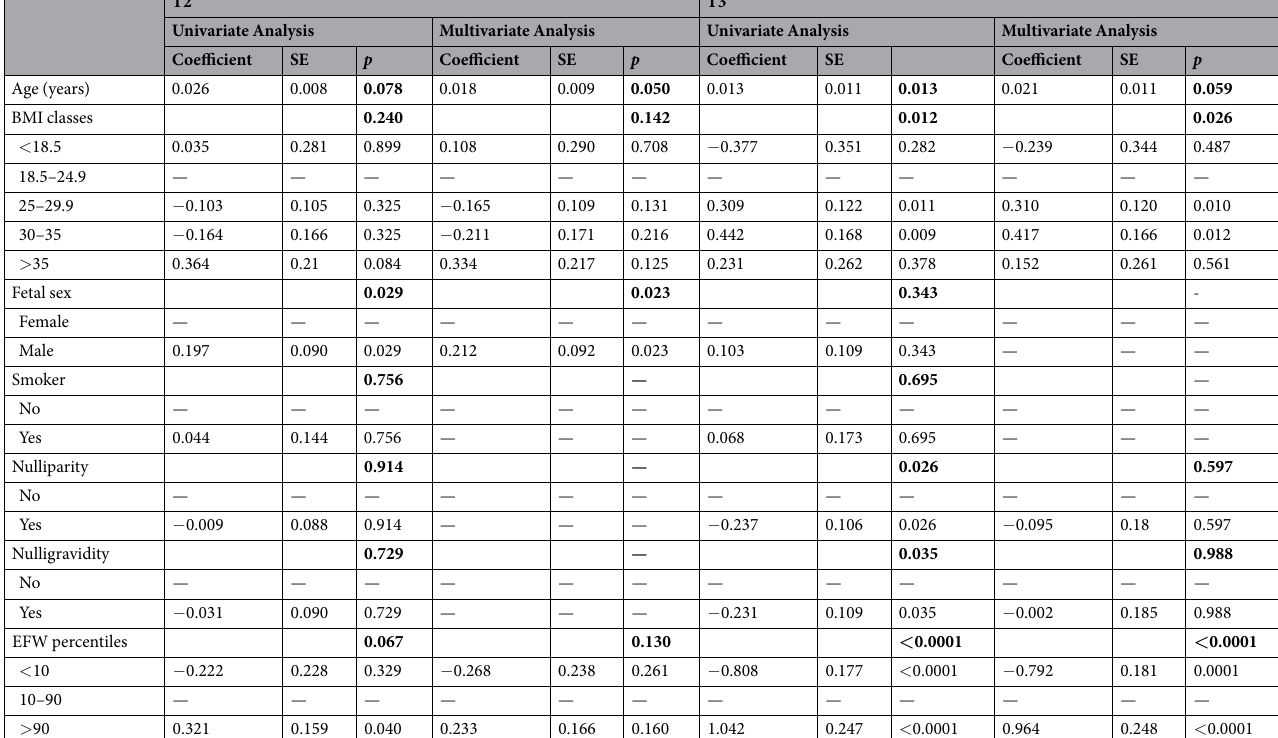
Table 3. Univariate and multivariate linear regression analysis for the deepest vertical pocket method (DVP) stratified by